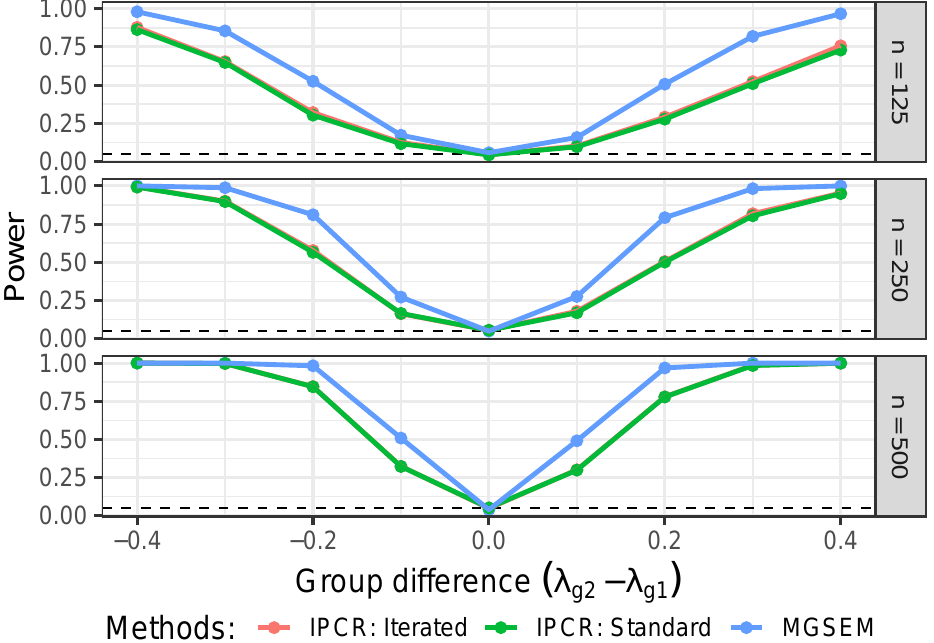
Figure 8. The power of standard and iterated IPC regression and MGSEMs to detect a group difference in the factor loading λ . The dashed line marks a power of